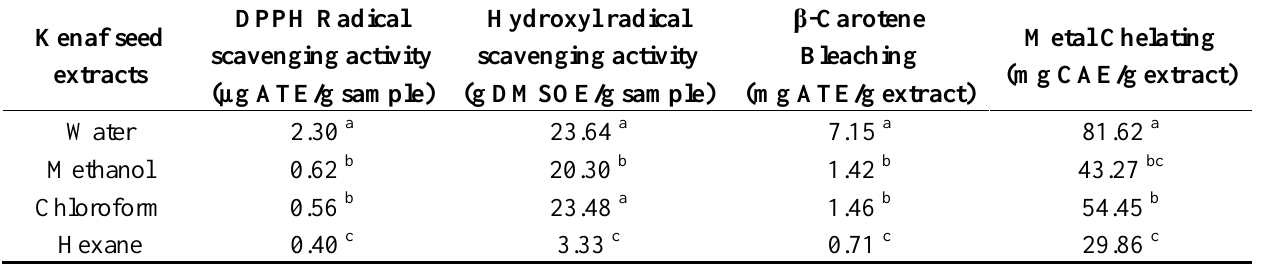
Table 2. Antioxidant activities of kenaf seed extracts.